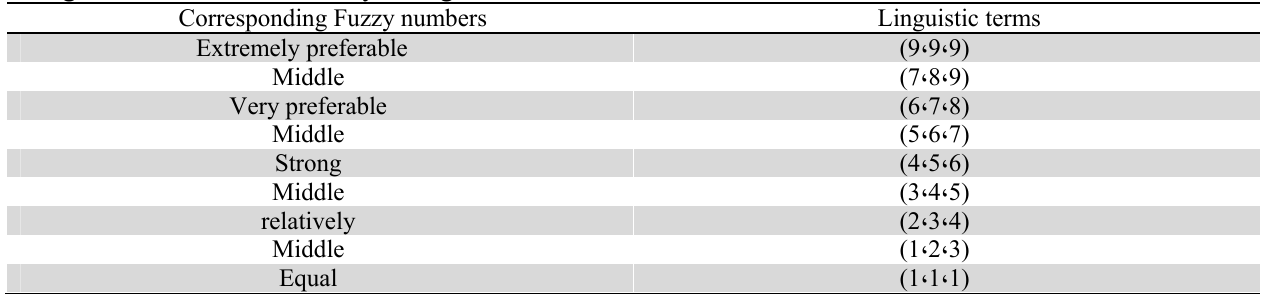
Linguistic terms for the fuzzy